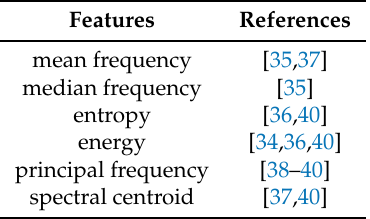
Table 11. Frequency features extracted from the consolidated dataset.